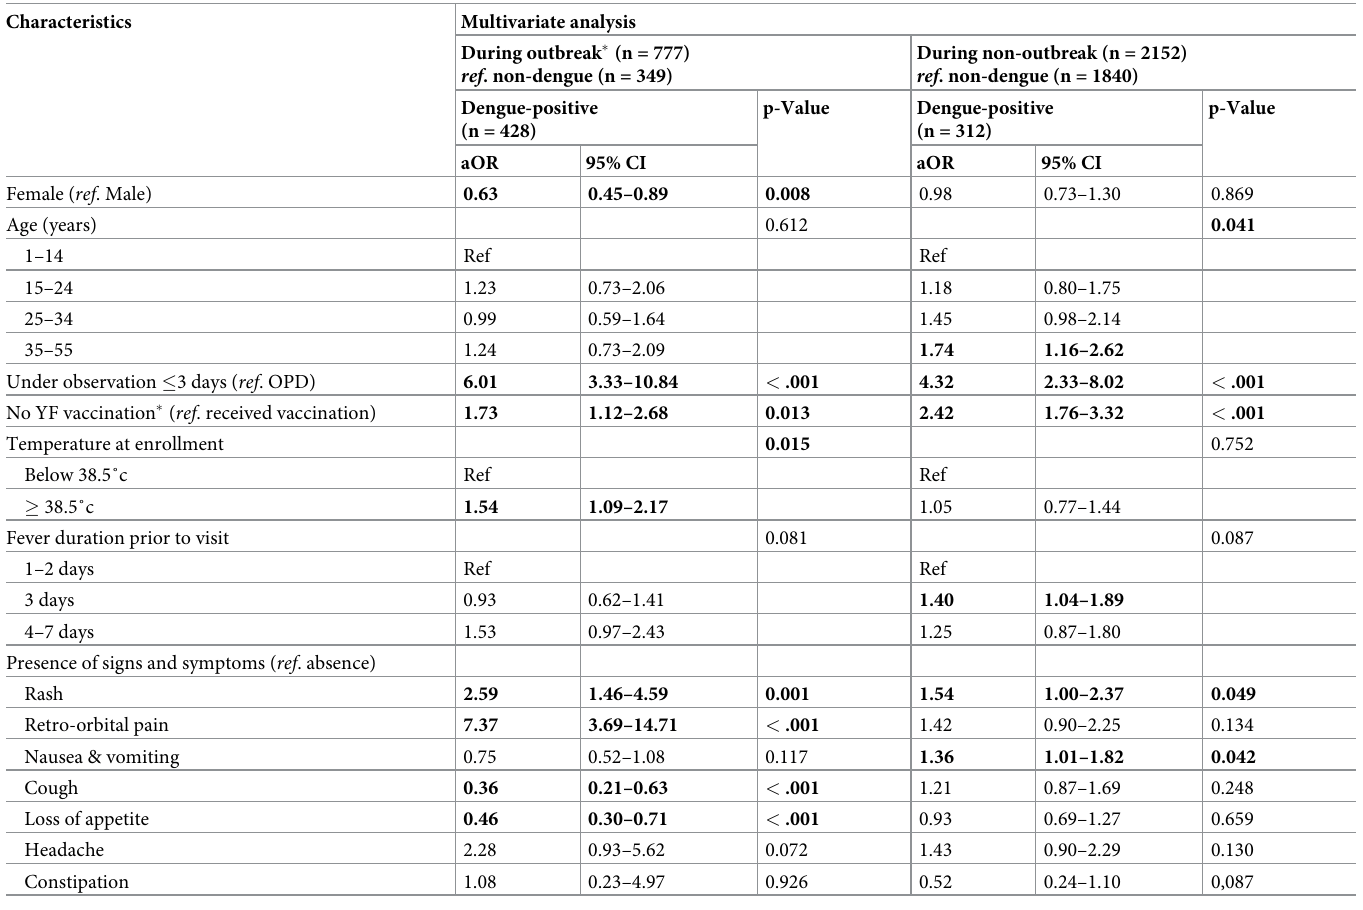
Table 5. Multivariate logistic analysis showing significant indicators and their odds ratios of dengue-positivity by outbreak or non-outbreak periods, in the facility- based fever surveillance established in Ouagadougou, Burkina Faso, between December 2014 and February 2017.